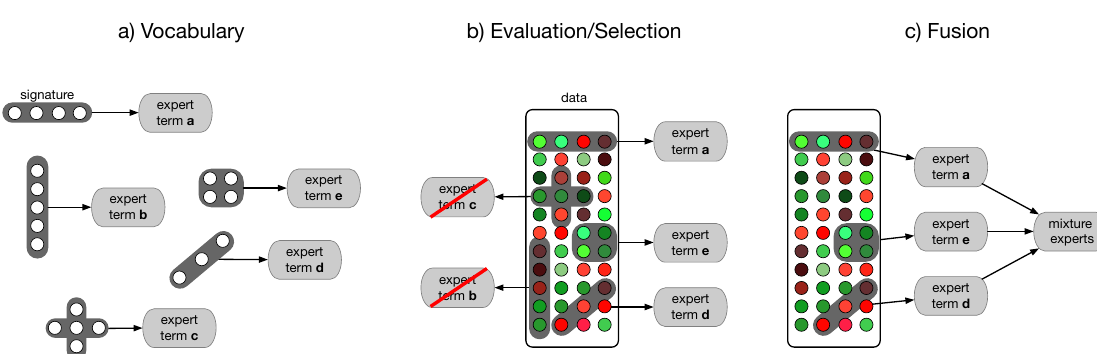
Figure 5. Schematic drawing of a semantic multi-classifier system (S-MCS): The training of a S-MCS uses prior domain knowledge in form of a vocabulary of selected semantic terms (e.g., KEGG pathways of GO terms) for the analysis of incoming gene expression profiles. Each term is analyzed independently by a separate expert (classifier) which focuses on the chosen subset of measurements. The selection of these experts is aggregated via a fusion architecture, leading to a “mixture of